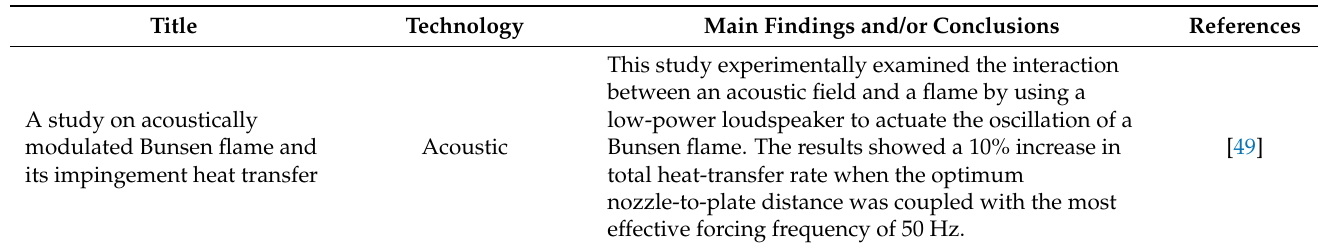
Table 2. Articles that focus on the use of acoustic excitation, OEC, or both technologies in the combustion